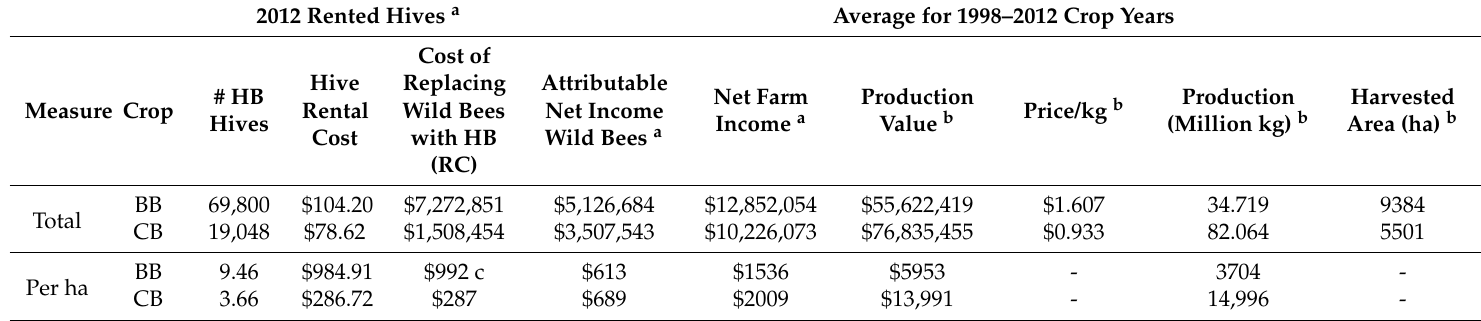
Table 3. 1998–2012 Maine, USA, wild blueberry (BB) and Massachusetts, USA, cranberry (CB) crop production values of